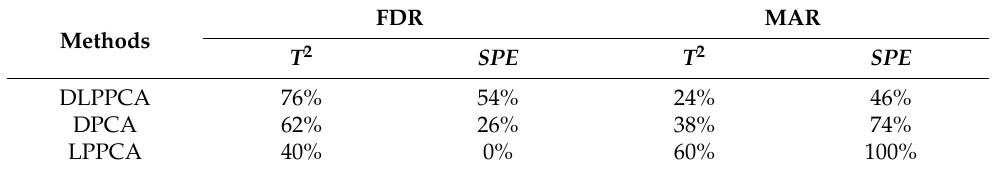
Table 4. FDR and MAR for transitional mode failure monitoring using DLPPCA, DPCA, and LPPCA.